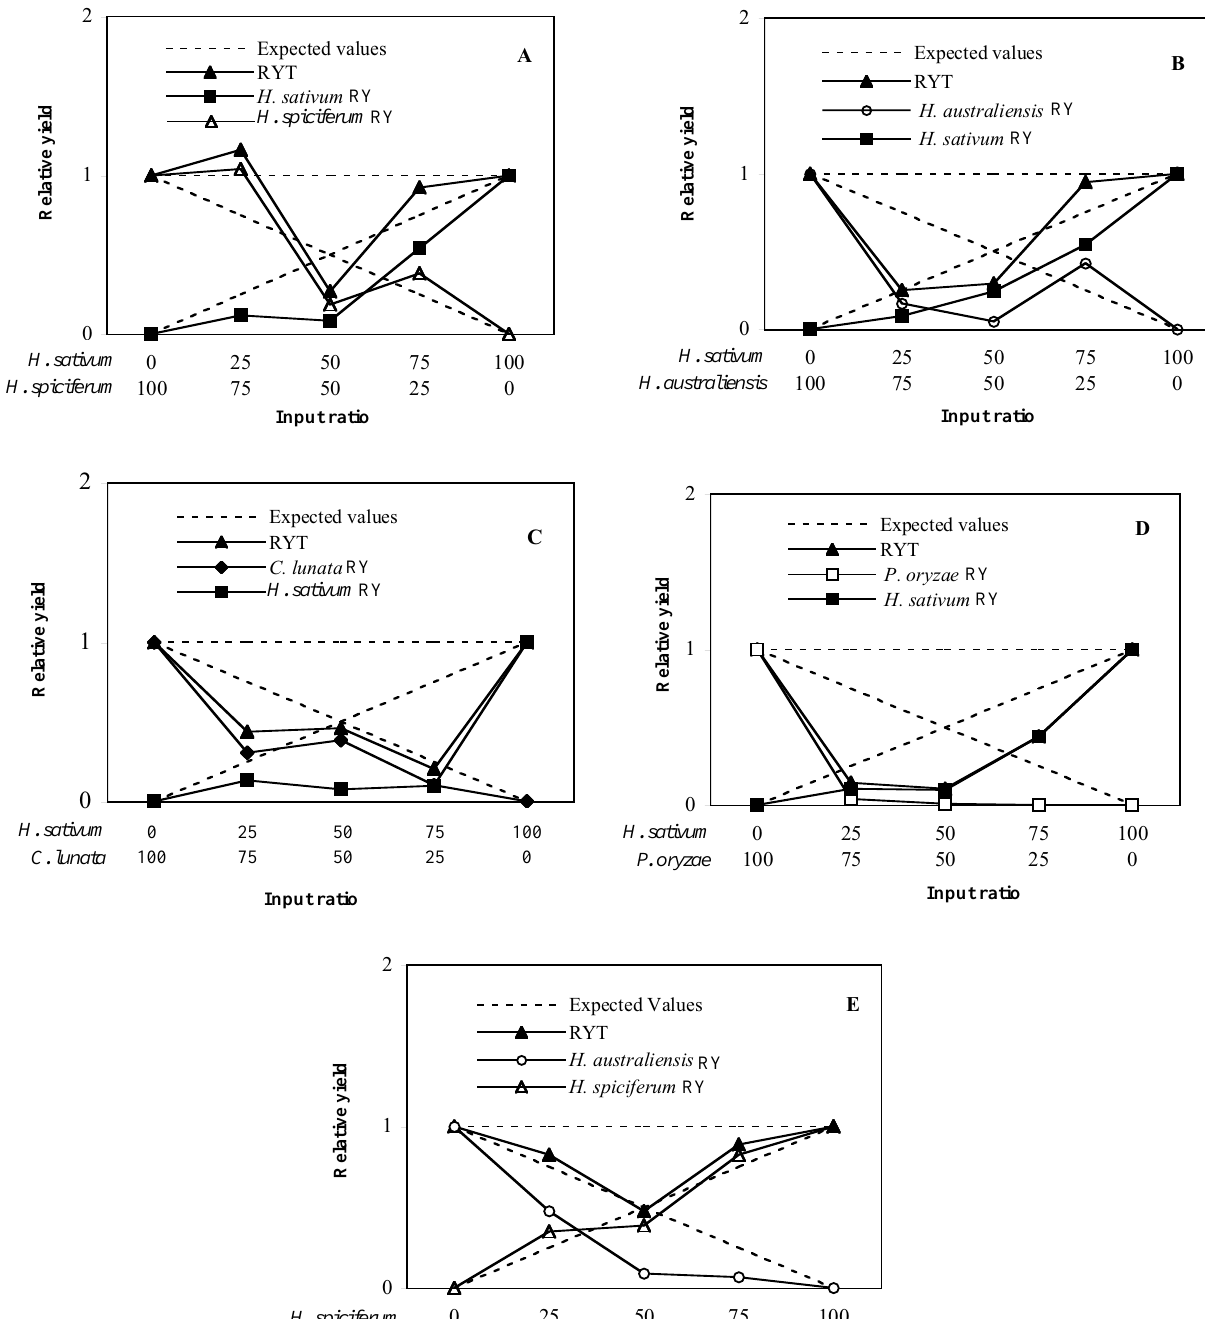
Fig. 2. Relative conidia production on rice leaves inoculated with H. sativum, H. spiciferum, H. australiensis, C. lunata, P. oryzae , alone and in combination, resulting from varied input ratio. RYT, relative yield total; RY, relative yield of each species. Expected values (dotted lines) are reference values indicating equal inter- and intraspecific